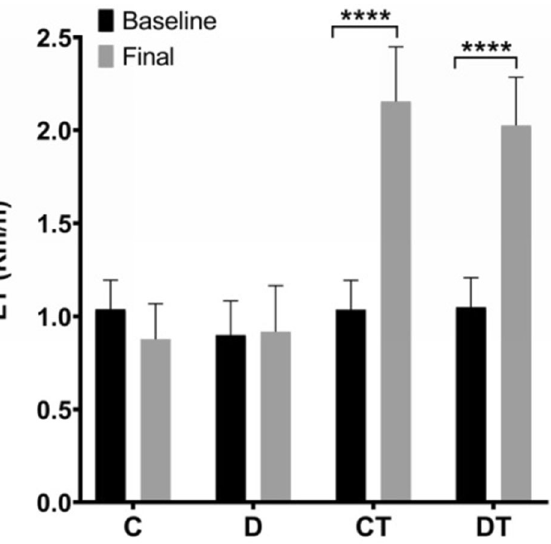
Figure 2. Maximal exercise test (ET). C: control (n = 10); D: doxorubicin-treated (n = 10); CT: control-trained (n = 10); DT: doxorubicin-trained (n = 10). One or Two-way ANOVA and Tukey’s post-hoc. ****p < 0.0001 above error bars in comparison to control